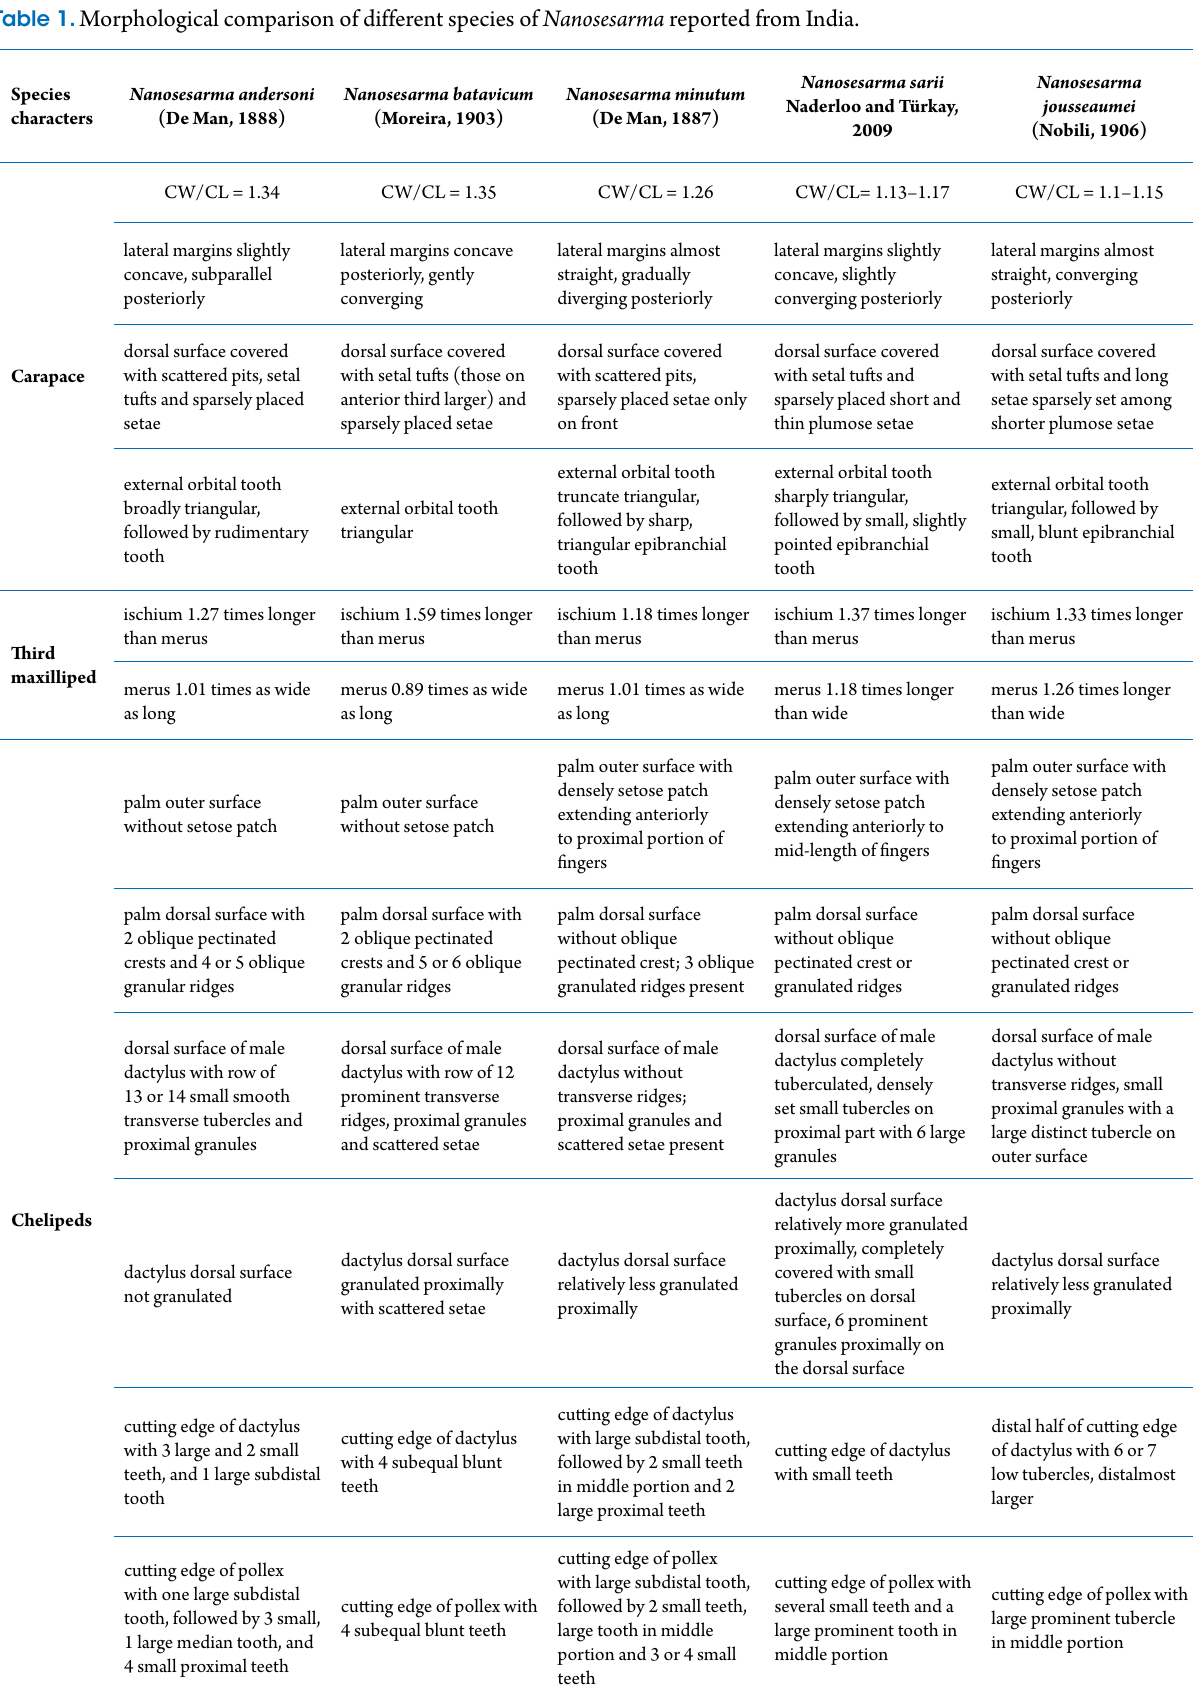
Table 1. Morphological comparison of different species of Nanosesarma reported from India. Species